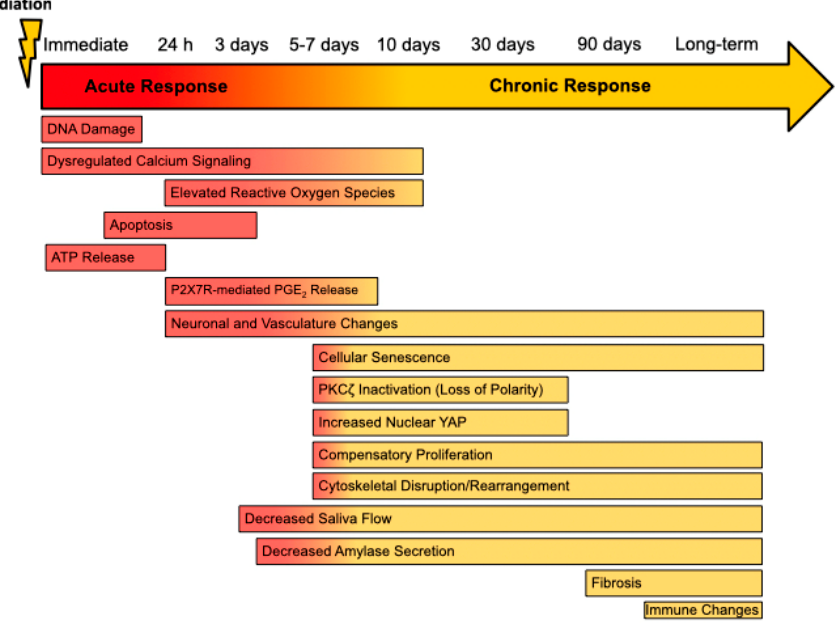
Figure 1. Timeline of Radiation-Induced Changes in the Rodent Salivary Gland. Following irradiation, rodent models show decreased saliva flow at approximately 3 days and a loss of amylase secretion reported as early as 4 days in rats post-IR [2,56,58]. In the acute phase, immediate DNA damage [6,59], rapid apoptosis of acinar cells [4,6,58], and elevated levels of intracellular calcium [45,46] and reactive oxygen species [45,46,60,61] contribute to acute loss of glandular function following irradiation. This period is also marked by release of ATP, which activates the P2X7 receptor (P2X7R), and P2X7R-dependent release of prostaglandin E 2 (PGE 2 ) in murine parotid cells [48]. During the transition phase, loss of apical / basolateral polarity as a result of PKC ζ inactivation [55,62,63], increases nuclear Yes-associated protein (Yap) levels [55,64], compensatory proliferation [62,65,66], cellular senescence [60,67,68], and cytoskeletal rearrangements [50,69], which contribute to long-term dysfunction. Changes in innervation and vasculature have been reported as early as 24 h post-IR [53], as well as at chronic time points [54,70]. Though inconsistently reported, fibrosis generally appears between 4 and 6 months following irradiation [1,44,71]. There is little information regarding the effect of irradiation on the immune landscape of the salivary glands in rodent models, although one study indicates changes at 300 days post-IR in mice [54].